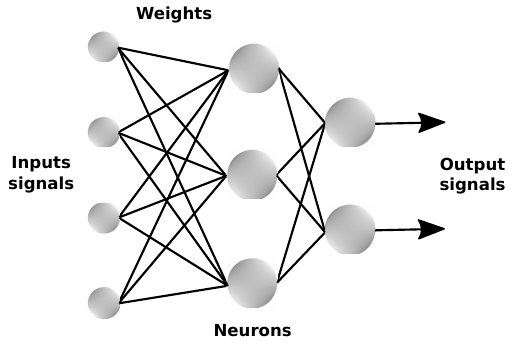
Figure 2. Basic structure of an artificial neural network. Source: Adapted from Oliveira [22].